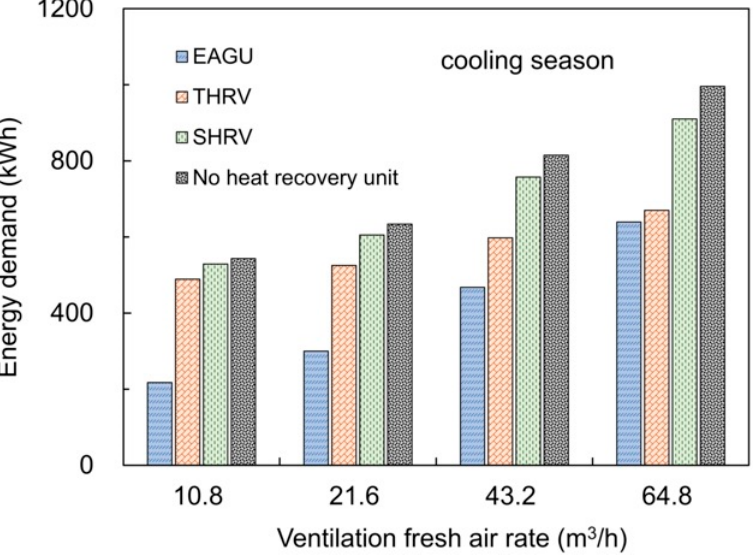
Figure 11. Effect of the ventilation fresh air rate on energy demand of the four cases in the cooling season.